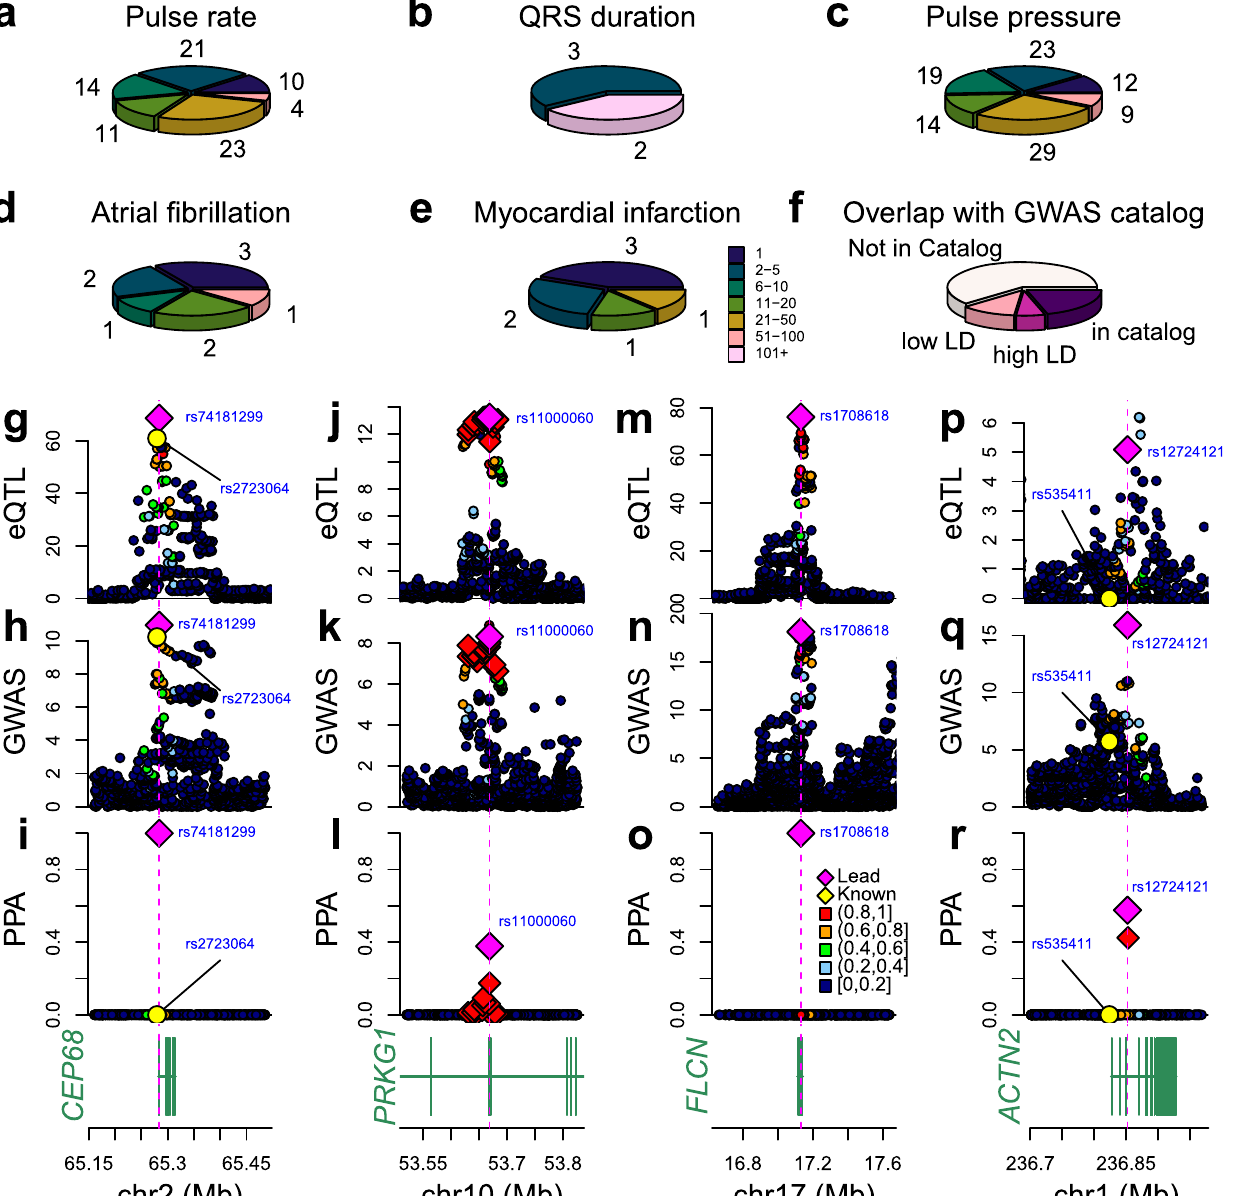
Fig. 6 | Fine mapping of stage and cell type- eQTLs colocalizing with cardiac traits.a – e Piecharts showing for eachcardiactraitthe distribution ofSNPsin 99% credible sets. The colorsindicate the number of SNPsand the numbersaround the perimeter indicate the number of credible sets. f Pie chart showing the overlap between the lead SNP at each GWAS signal in the fi ve cardiac traits and the index SNP for the GWAS signal in the GWAS catalog for the same trait. SNPs in high LD